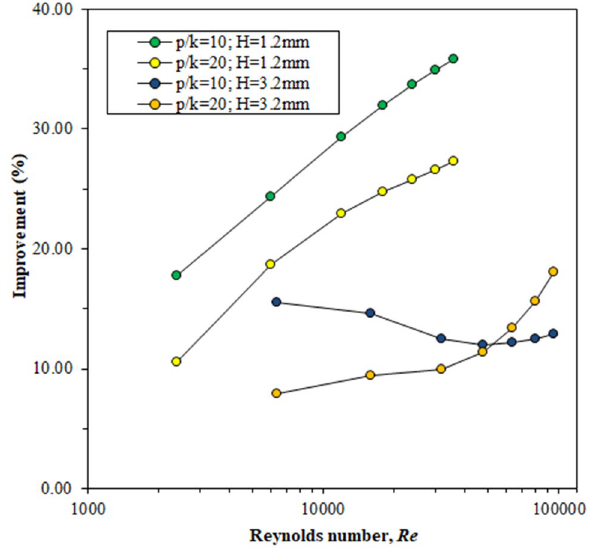
Fig. 15 Percent improvement of fitness values after calibration for different narrow channel and flow